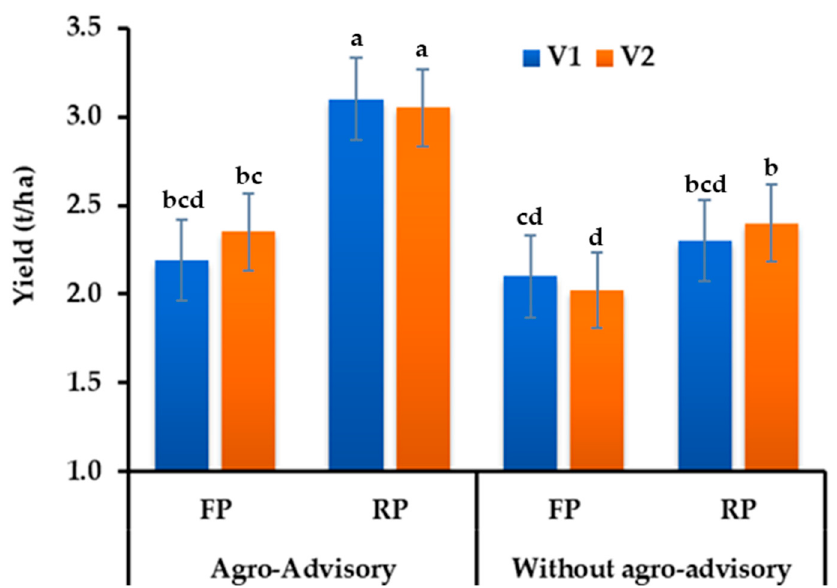
Figure 7. Effect of agro-advisory on maize crop yield under different farming practices. Means denoted by the same letters indicate no significant difference at p < 0.05 as evaluated by Tukey’s HSD test. V1 (RCM-1-76) and V2 (DA 61 A) are two maize crop varieties selected for this study.